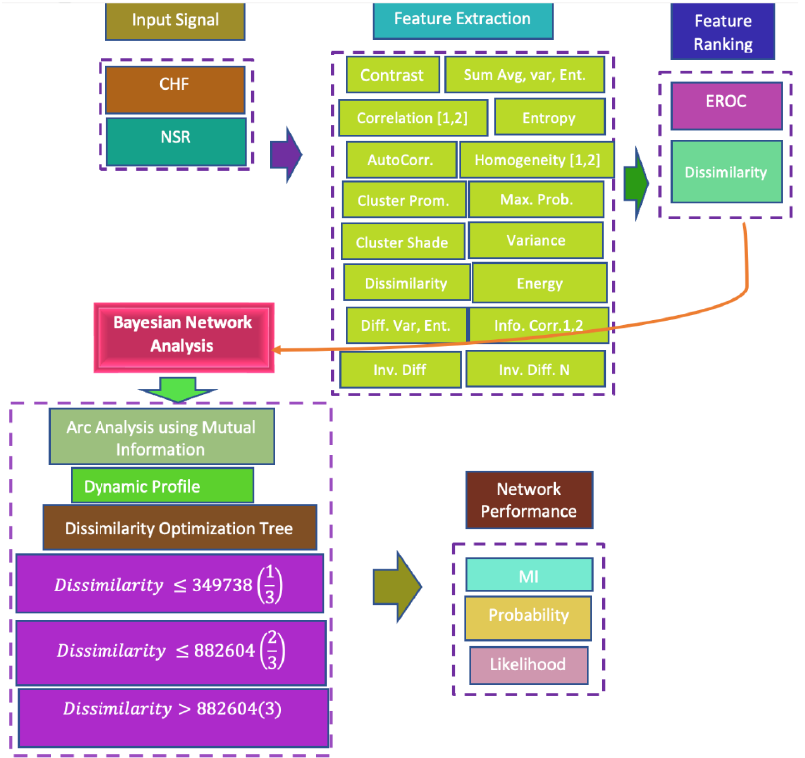
Figure 1. Schematic diagram, based on Bayesian inference analysis, of target nodes based on ex- tracted fuzzy entropy features. fuzzy entropy